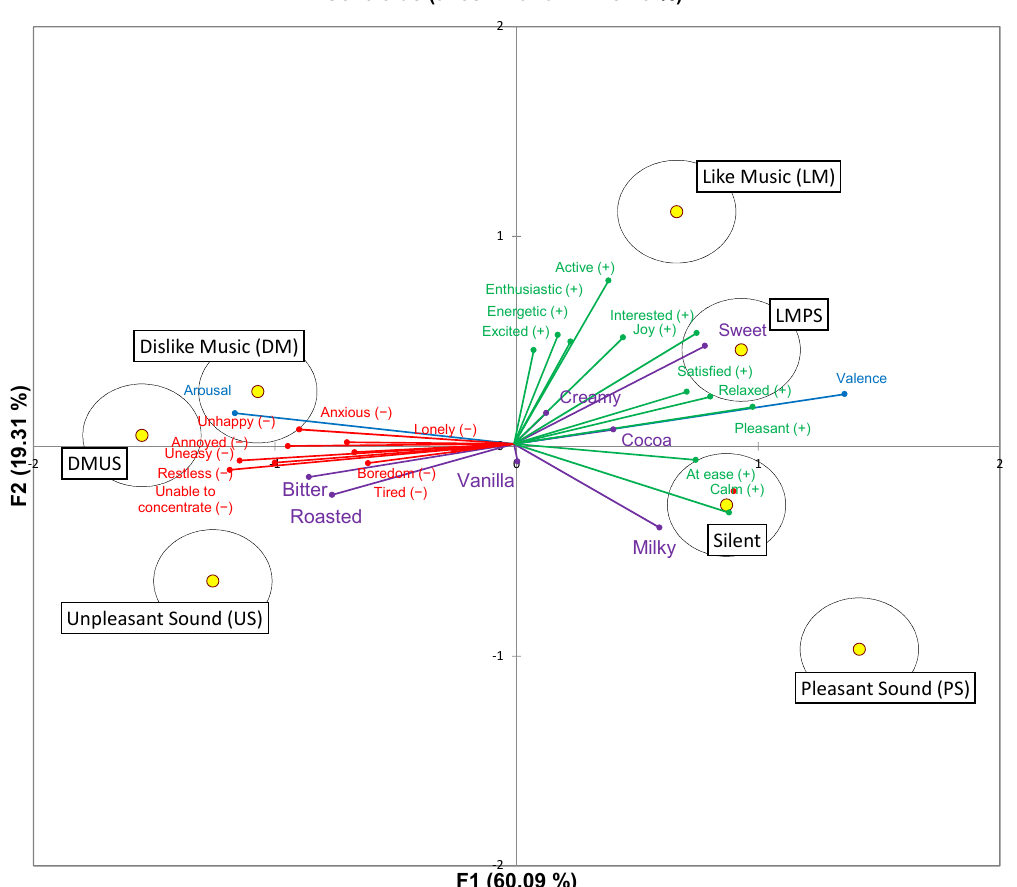
Figure 4. Joint canonical variate analysis (CVA) scores and loadings plots of dominance durations of sensations and emotional responses. A Hotelling–Lawley MANOVA test showed significant sample differences ( F (180,1992) = 5.07, p < 0.01, partial eta squared = 0.31) based on sensory attributes and emotional responses. To aid visualisation, positive emotional responses are labelled green, negative emotional responses are labelled in red, affective measures are labelled in light blue, and sensory attributes are labelled in orange.